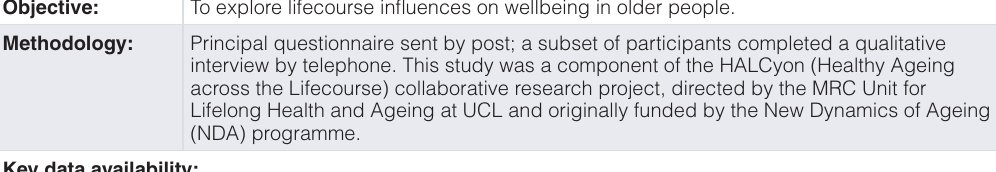
Table 6. Hertfordshire Cohort Study wellbeing